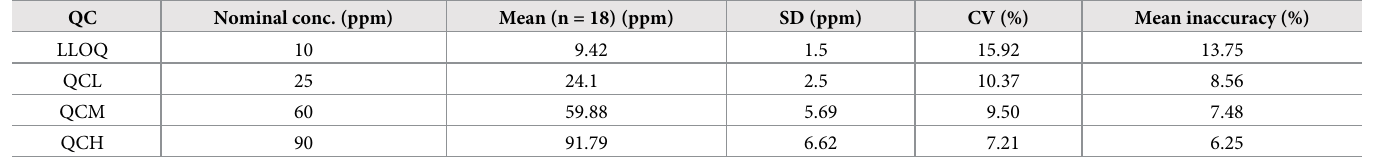
Table 8. Between-assay coefficients of variation and mean inaccuracies. QC Nominal conc.